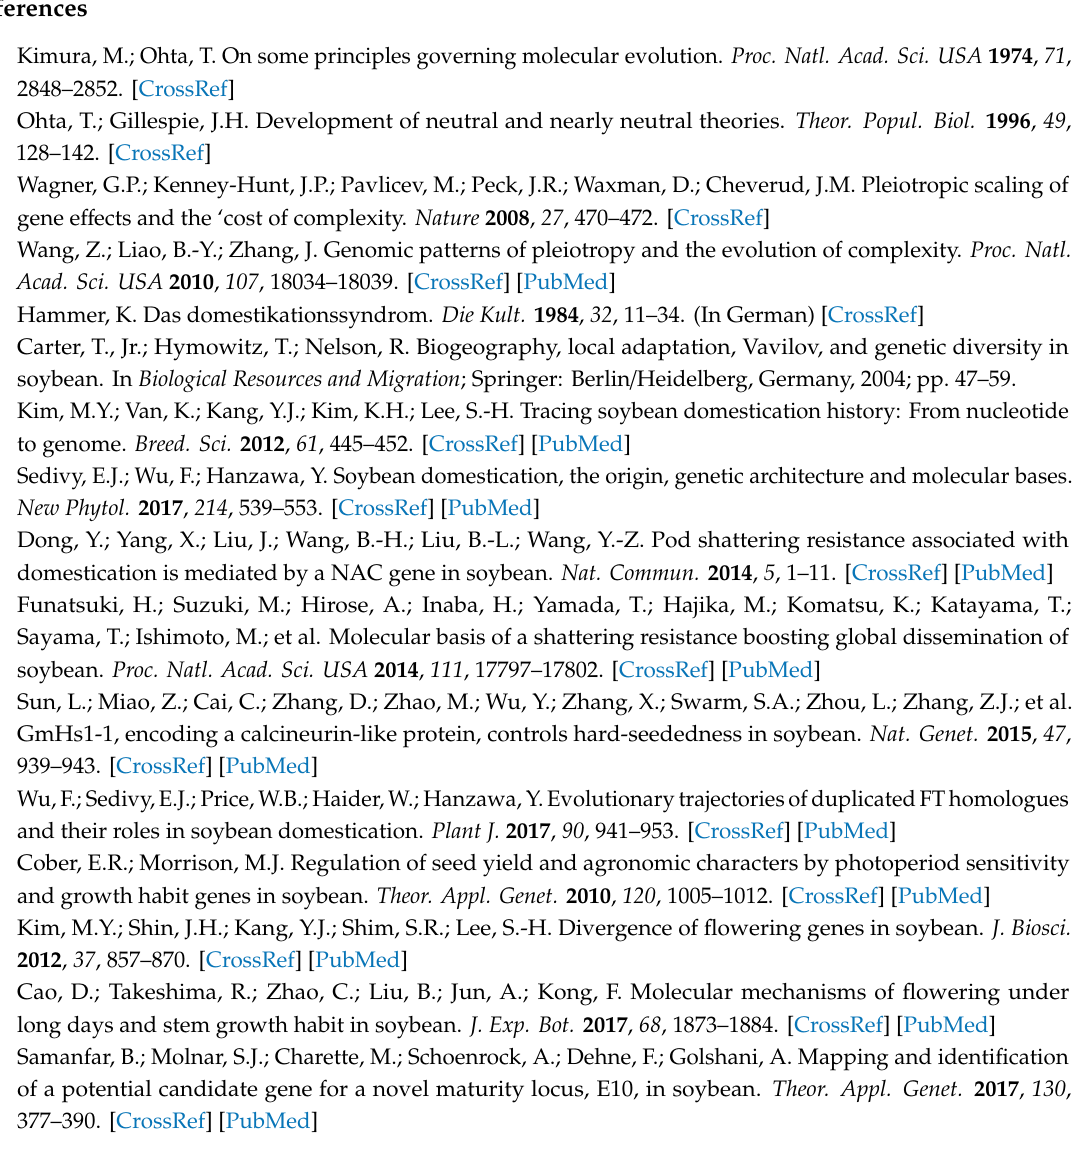
Figure S1: Phenotype correlation between di ff erent field sites; Figure S2: Complete linkage map; Table S1: SNP alleles in the mapping population; Table S2: E1 alleles in the mapping